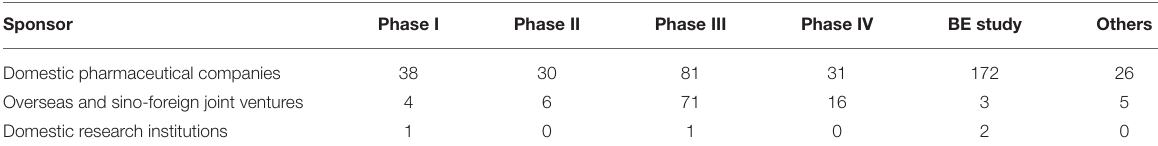
TABLE 9 | Phases of clinical trials by different sponsors.